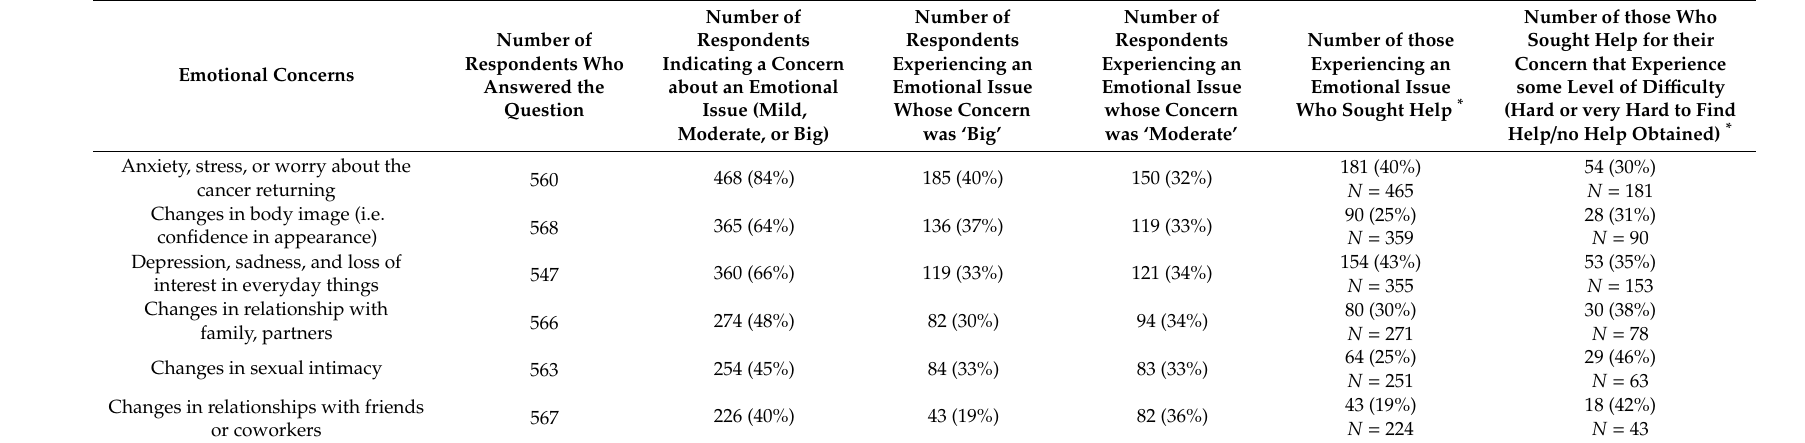
Table 3. Emotional concerns prevalent and ease of accessing help in AYA sample.